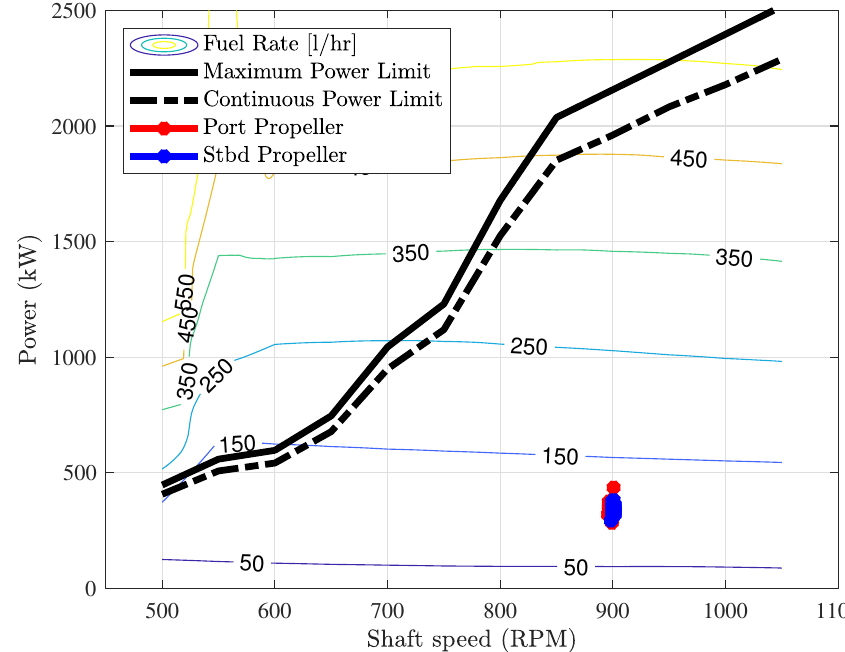
Figure 13. Propeller torque.